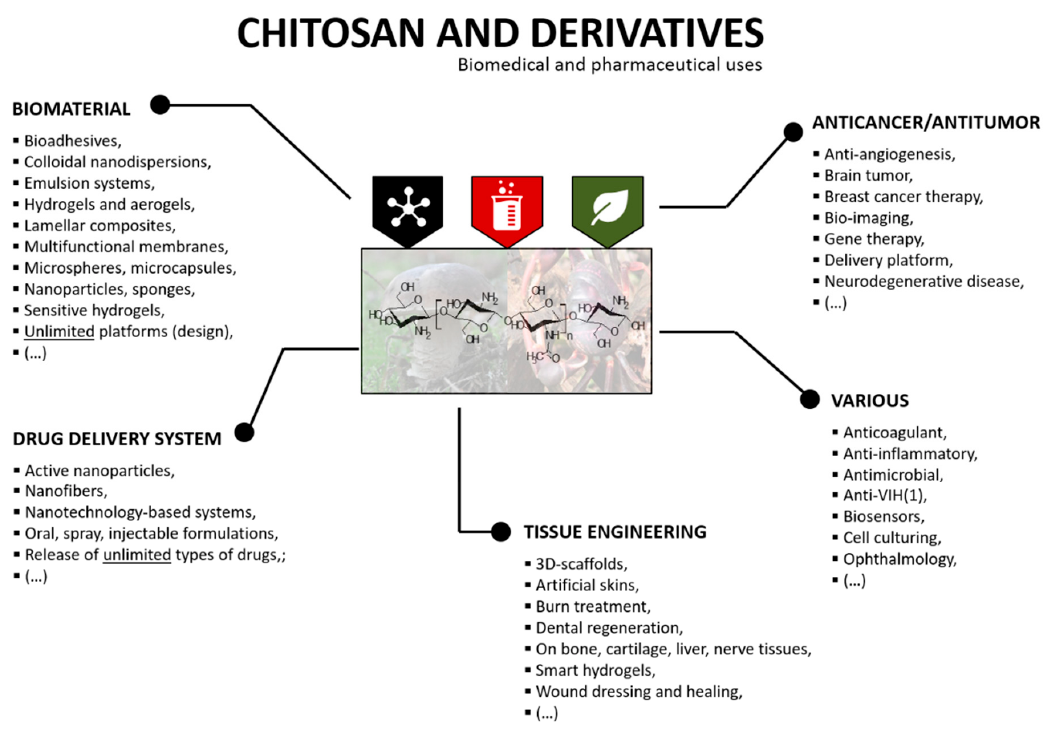
Figure 9. Various applications of chitosan and derivatives in biomedical and pharmaceutical fields.